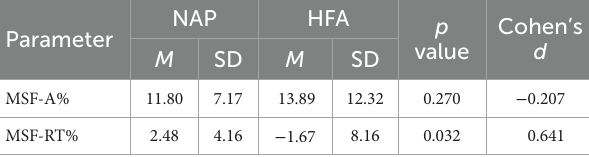
TABLE 4 Multisensory facilitation of accuracy and response times.